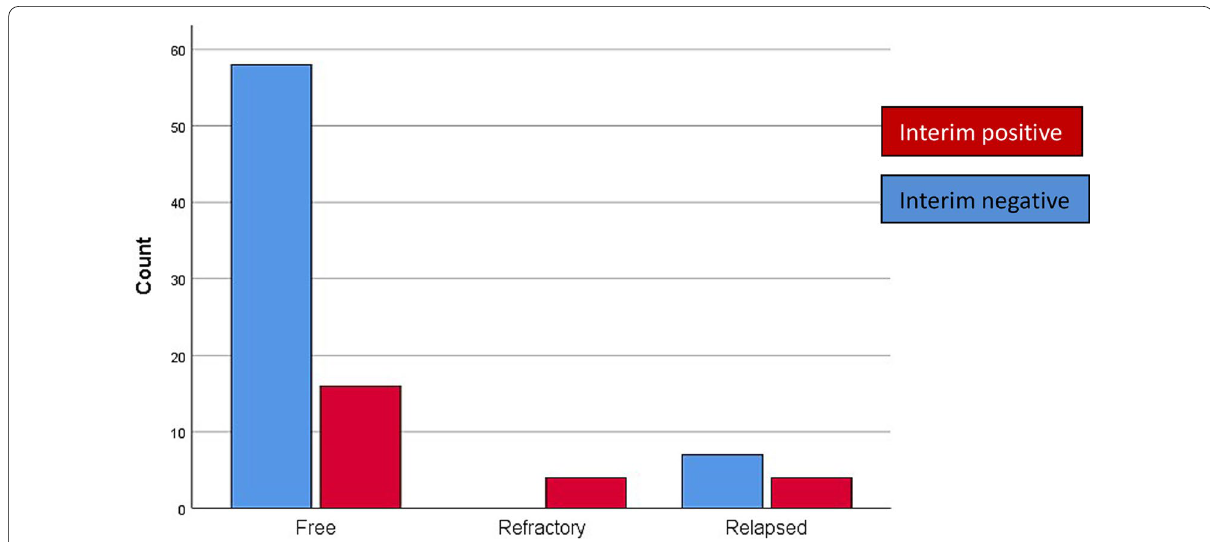
Fig. 1 Response to therapy in interim negative and positive group